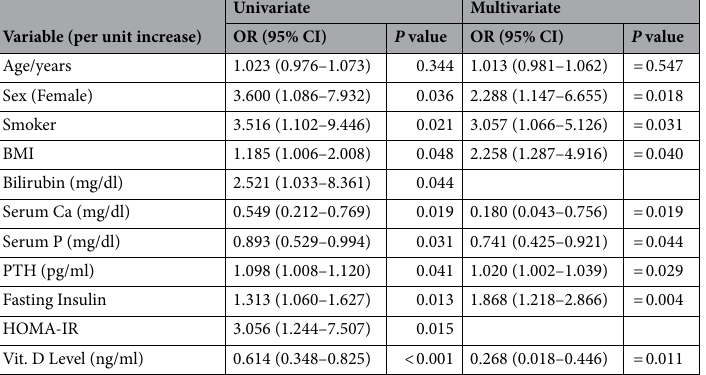
Variable (per unit